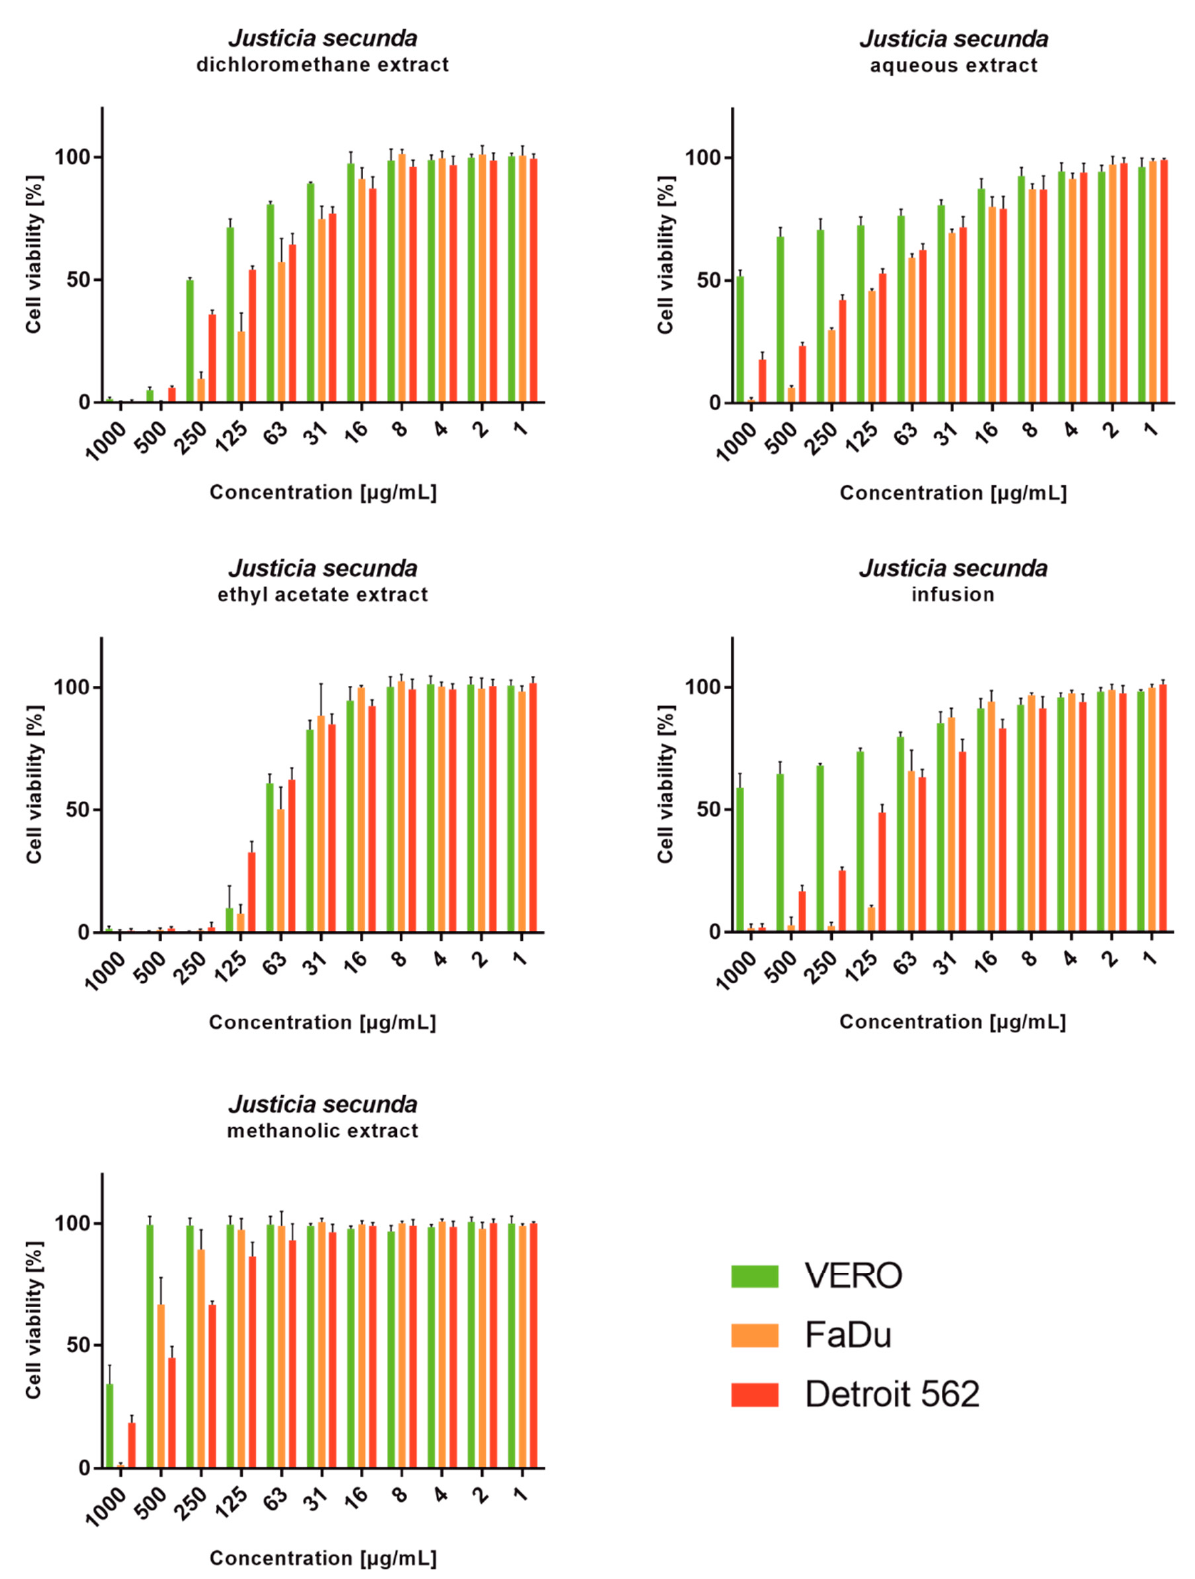
Figure 2. Viability of cell lines treated with different concentrations of Justicia secunda extracts (VERO—cell line from the kidney of an African green monkey; FaDu—cell line from hypopharyngeal carcinoma; Detroit 562—cell line from pharyngeal carcinoma) .